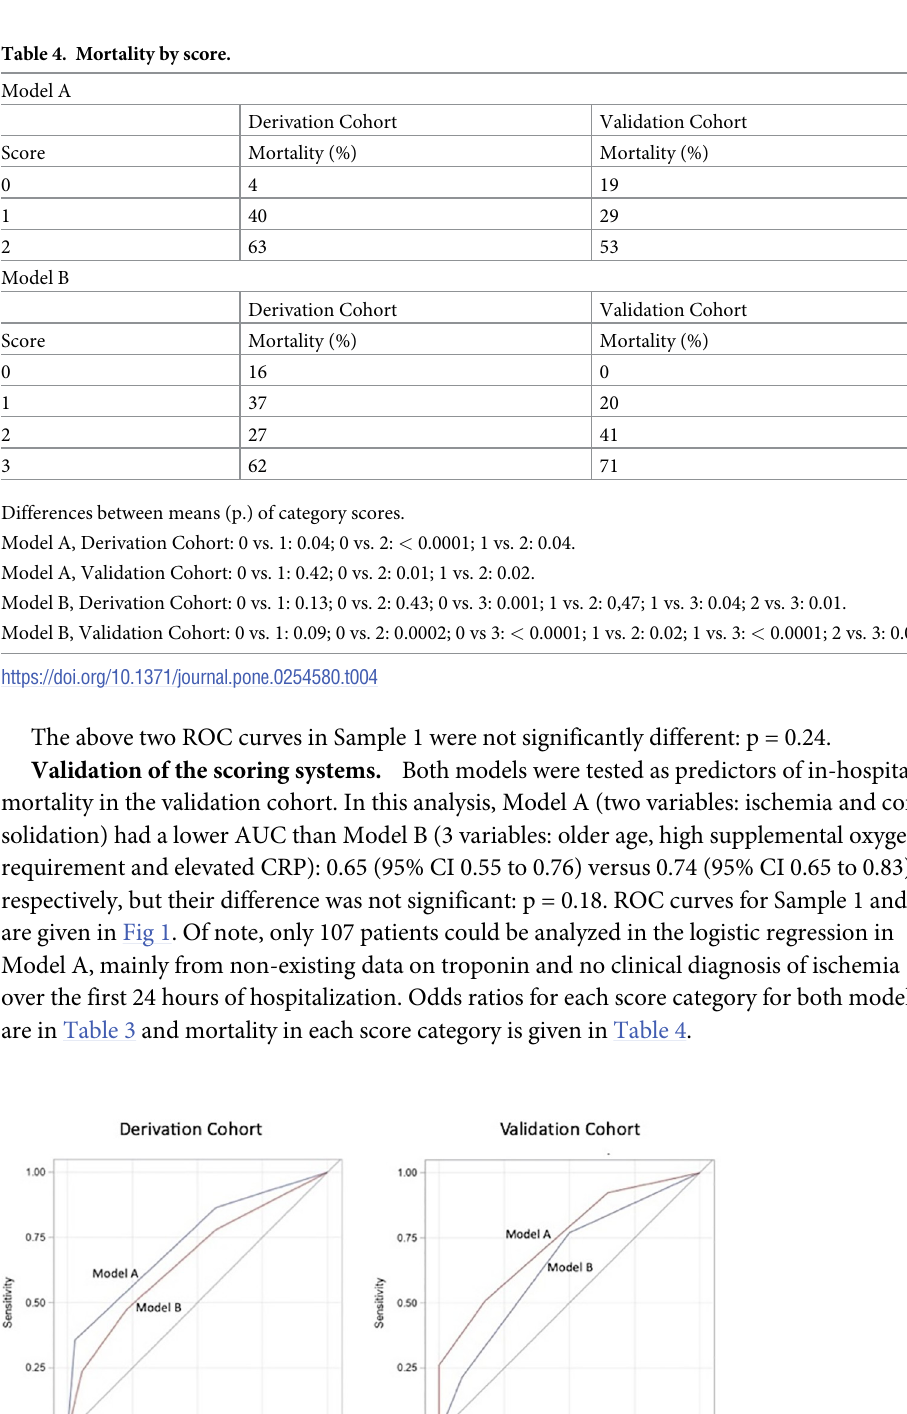
Fig 1. ROC curves in the derivation and validation cohorts. Model A: Scoring based on two variables: presence of pneumonia, ischemia; score can range from 0–2. Model B: Scoring based on three variables: age over 65, high supplemental oxygen requirement, C-reactive protein over 10. Presence of each given a score of 1; score can range from 0–3.